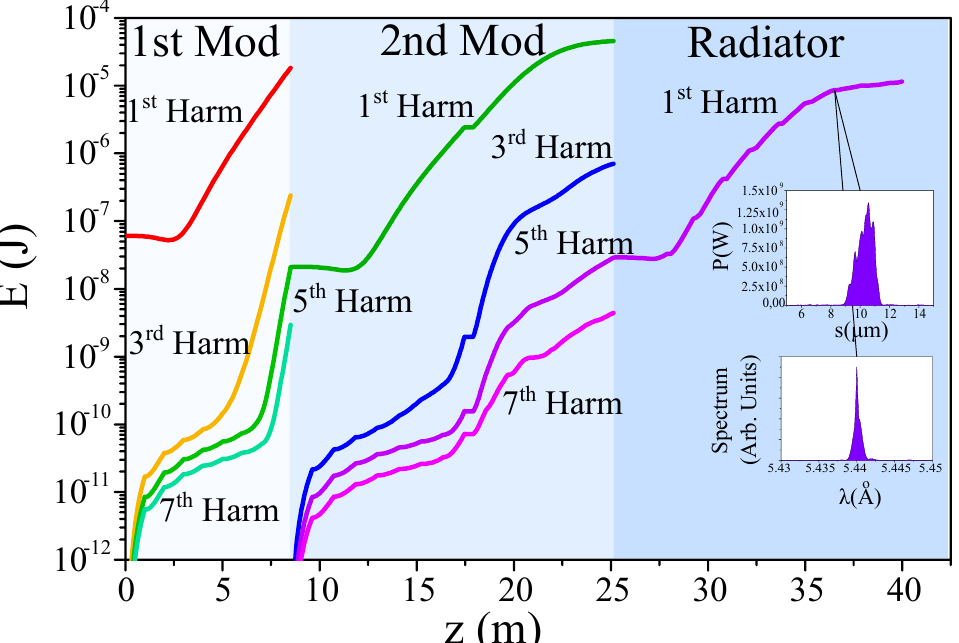
Figure 6. 5 × 5 cascade with the seed provided by a FEL oscillator: FEL energy of fundamental and harmonics generated in the various modules are presented vs the coordinate z in the undulator. Seeded cascaded fresh-bunch case. First modulator (1st Mod) with 5 cm period. Second modulator (2nd Mod) with 2.8 cm period. Radiator with 1.2 cm period. The FEL simulations have been performed with GENESIS 1.3 [35]. In the boxes, the temporal and spectral distrubution of the